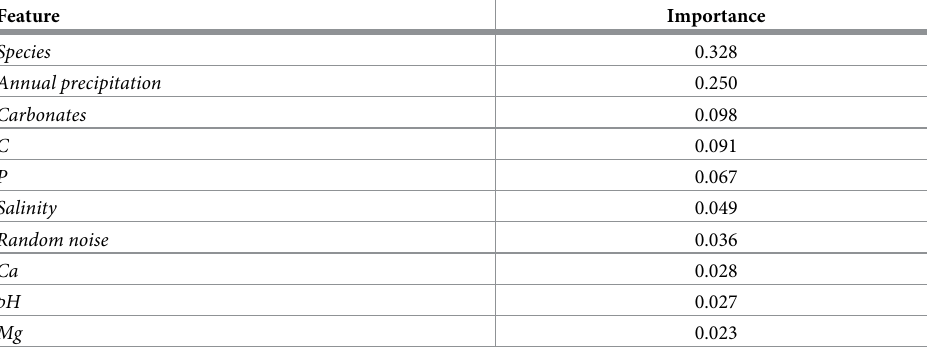
Table 1. Feature importance for the Random Forest model with the ABIOTIC set of